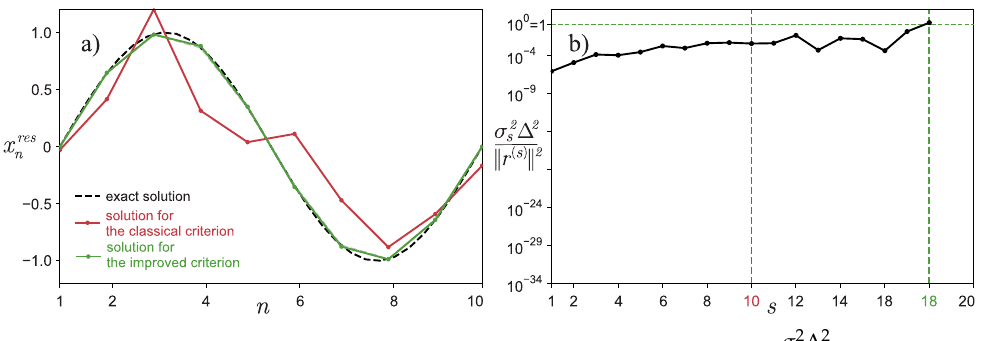
Figure 5. ( a ) Graph of x res n depending on the component index n . ( b ) Graph of the iteration number s